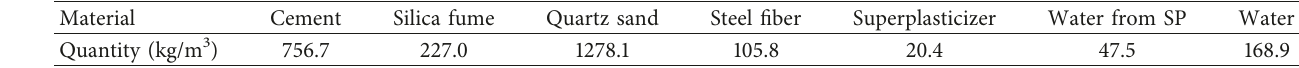
Table 2: Mixture proportions of RPC.